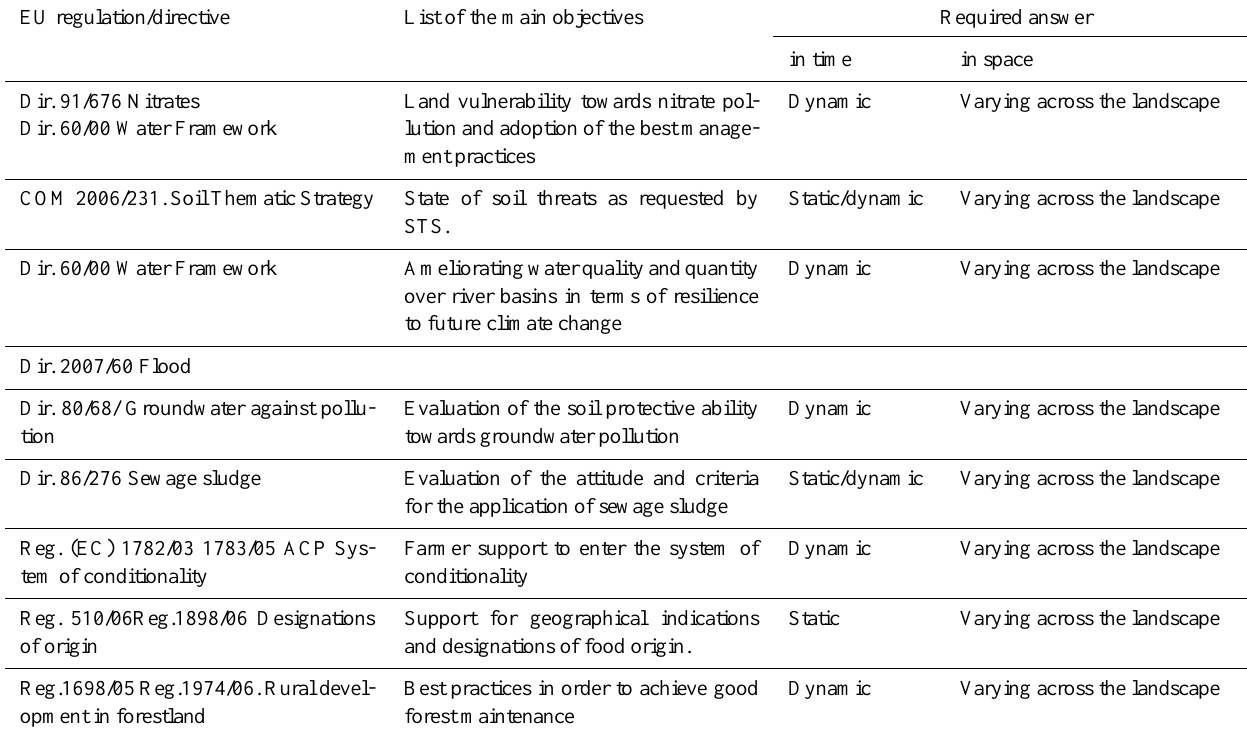
Table 1. Some important EU regulations concerning the management of agricultural/forestry and environmental issues. Abbreviations: Dir. – Directive; Reg. – Regulation; COM – communication.